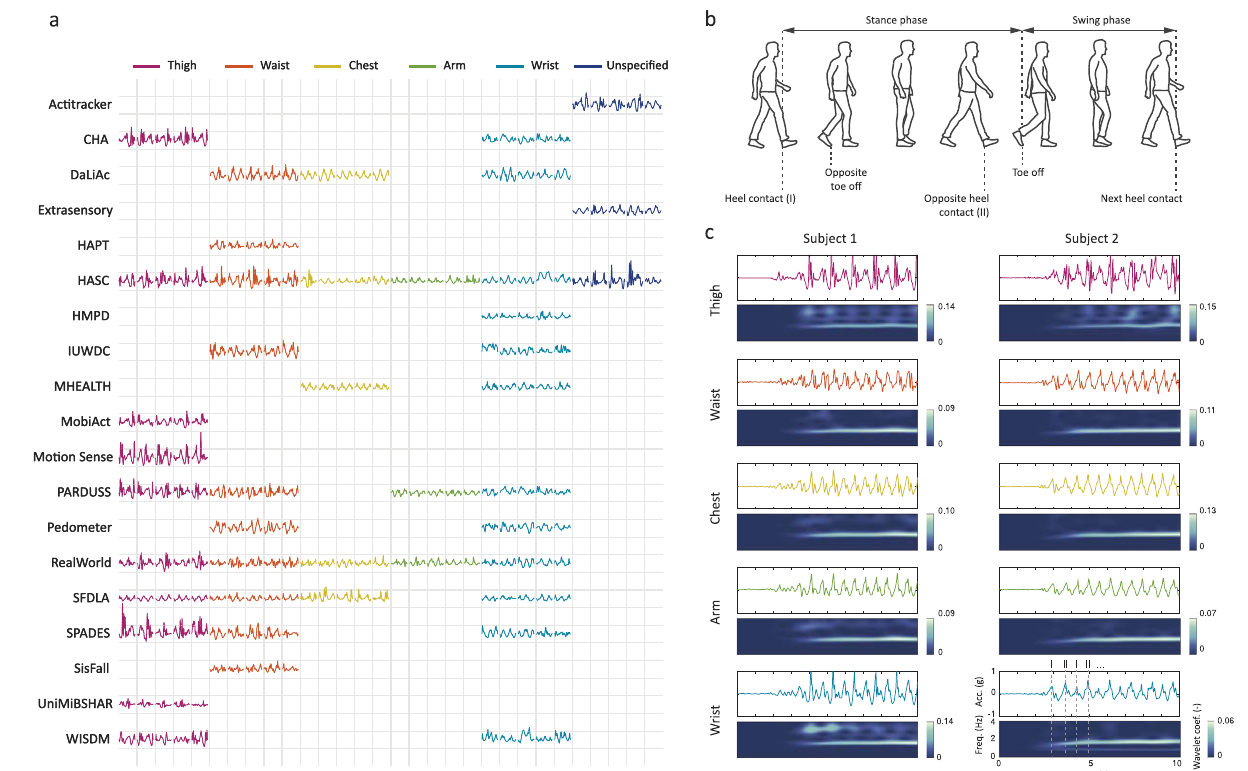
Fig. 1 Human gait and accelerometer data collected using body-worn devices. a . Vector magnitude of raw accelerometer time series of walking strides measured at different body locations. Strides were extracted for fi ve randomly selected subjects in each study and at each location available in that study. Vertical grid lines separate strides of different subjects, and horizontal grid lines mark stride acceleration equal to + 1 g and − 1 g above and below, respectively, of the acronym of the corresponding study. Colors indicate approximate locations of sensing devices. b . Walking activity is typically understood as a cyclic series of movements initiated the moment the foot contacts the ground, followed by the stance phase (i.e., when the foot is on the ground) and the swing phase (i.e., when the foot is in the air); the cycle is completed when the same foot makes contact with the ground again. c . Several examples of resting and walking acceleration signals collected simultaneously using smartphones at different body locations (thigh, waist, chest, arm) and a smartwatch worn on the wrist by two subjects. Corresponding time-frequency representation were computed with